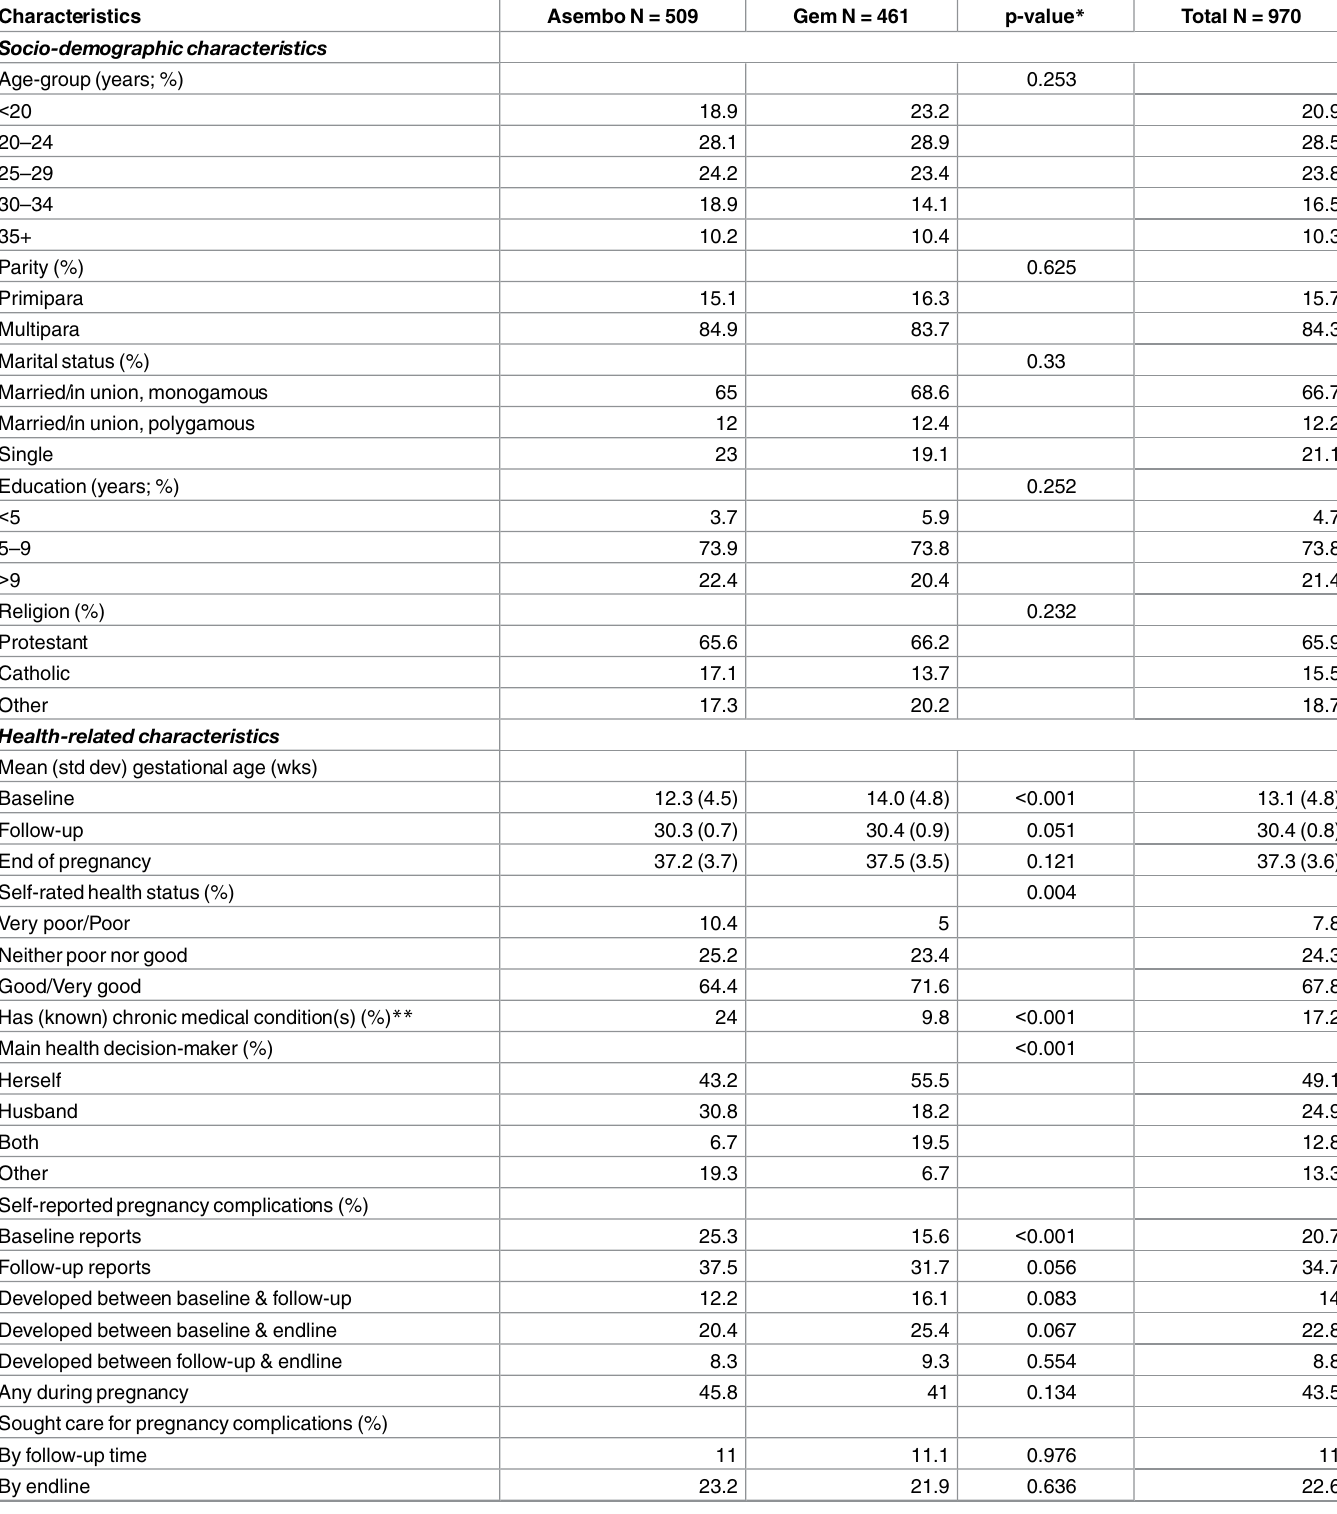
Table 1. Study population